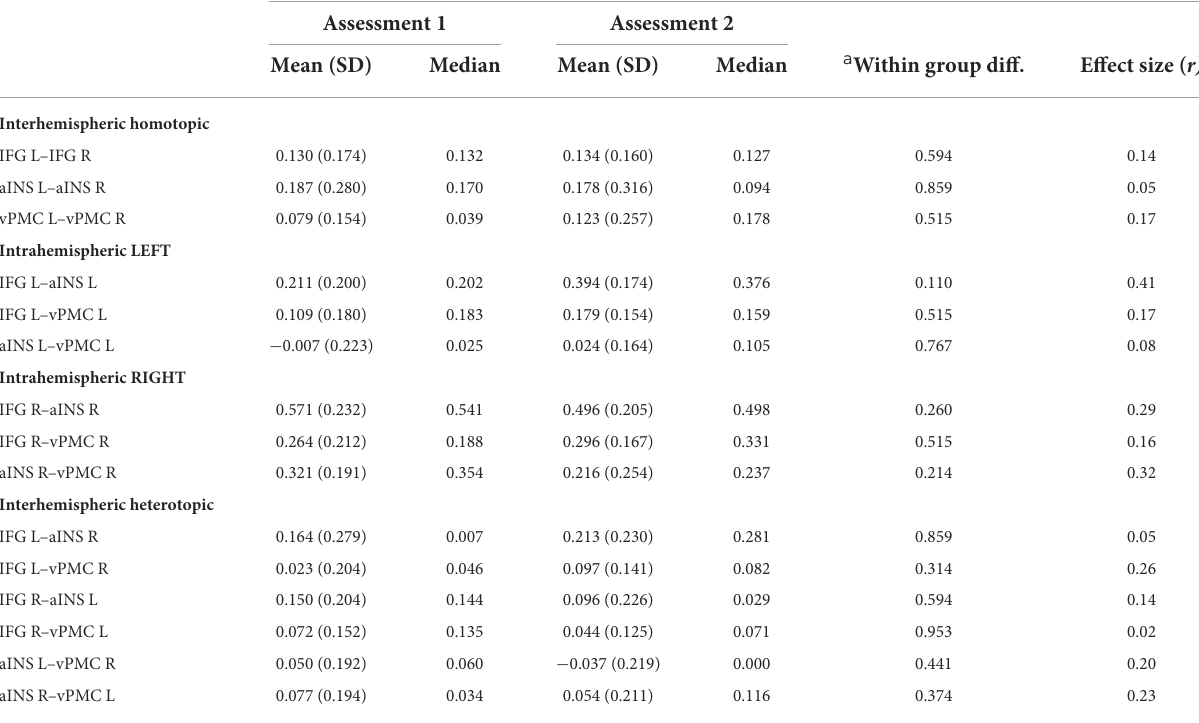
TABLE 9 Functional connectivity at first and second assessment, participants with AOS ( n =